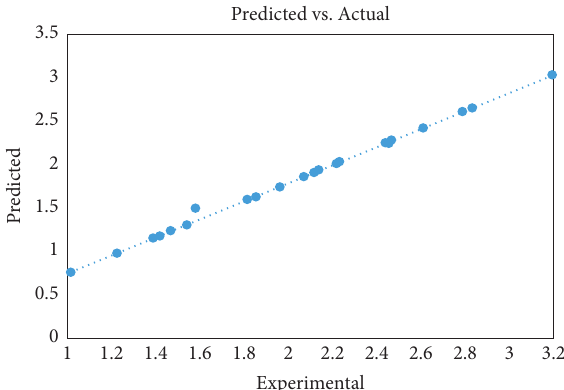
Figure 13: Correlation graph for Scheme B specimen.